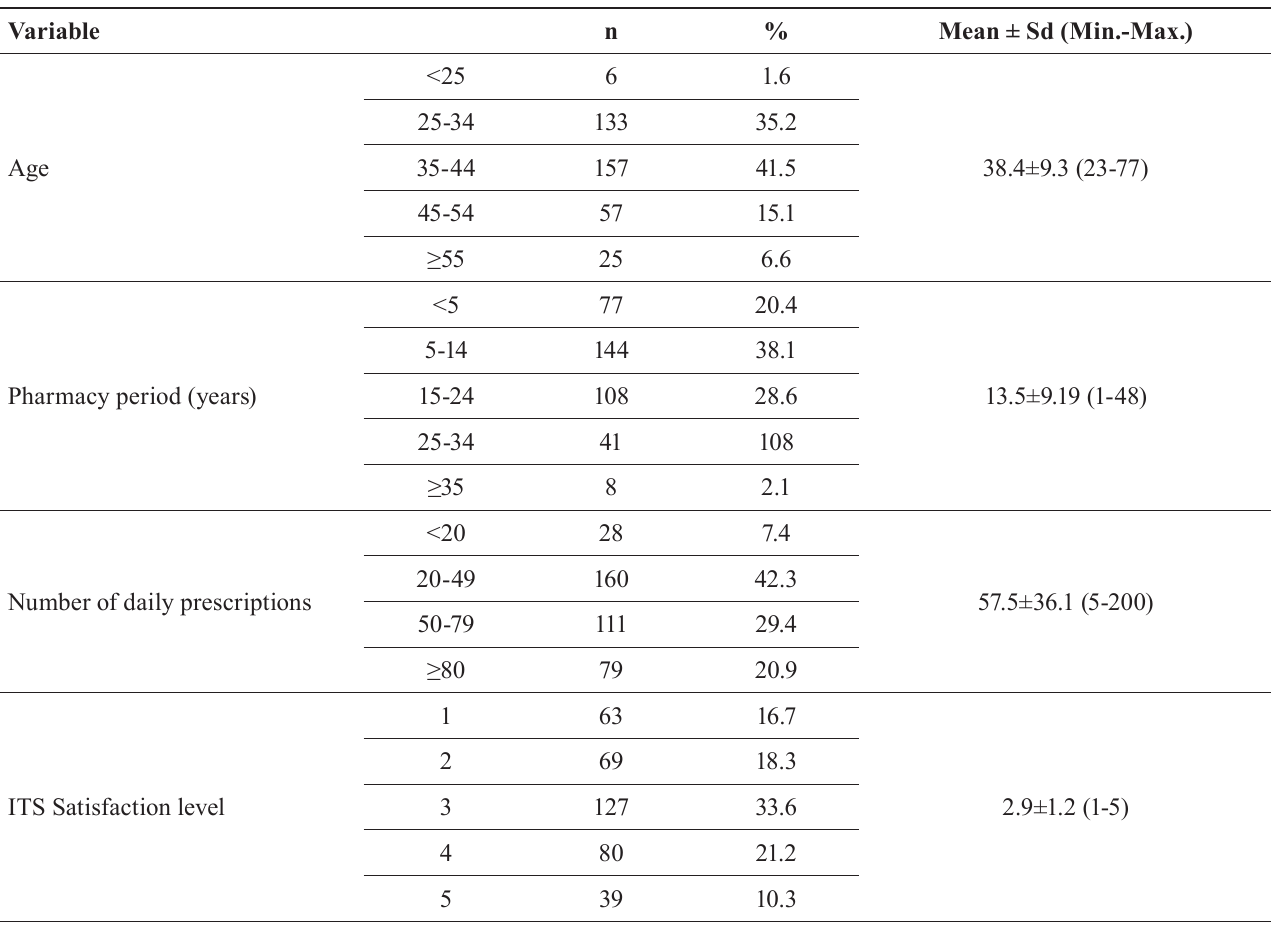
TABLE I - M ain characteristic features of participating pharmacists Variable n % Mean ± Sd